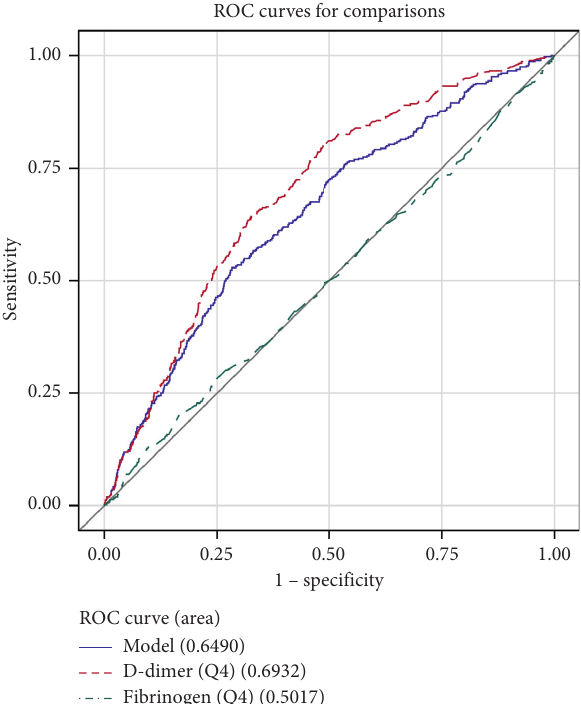
Figure 5: ROC curve for comparisons of D-dimer, fibrinogen, and combination of them in patients (age >